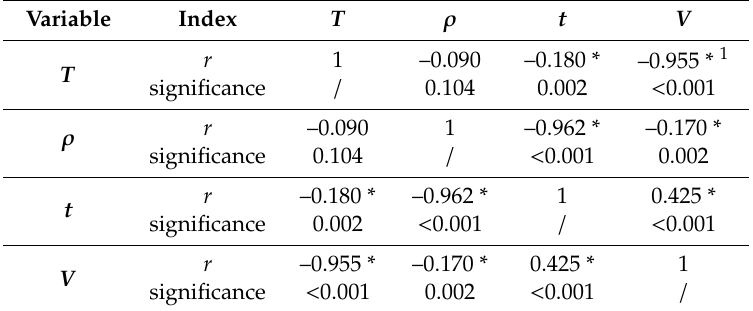
Figure 3. Measured PA signal in response to ( a ) ρ at 24 °C and ( b ) T at 0.997 g/cm 3 . Inset: Dependence of wave velocity on ( a ) ρ and ( b ) T .